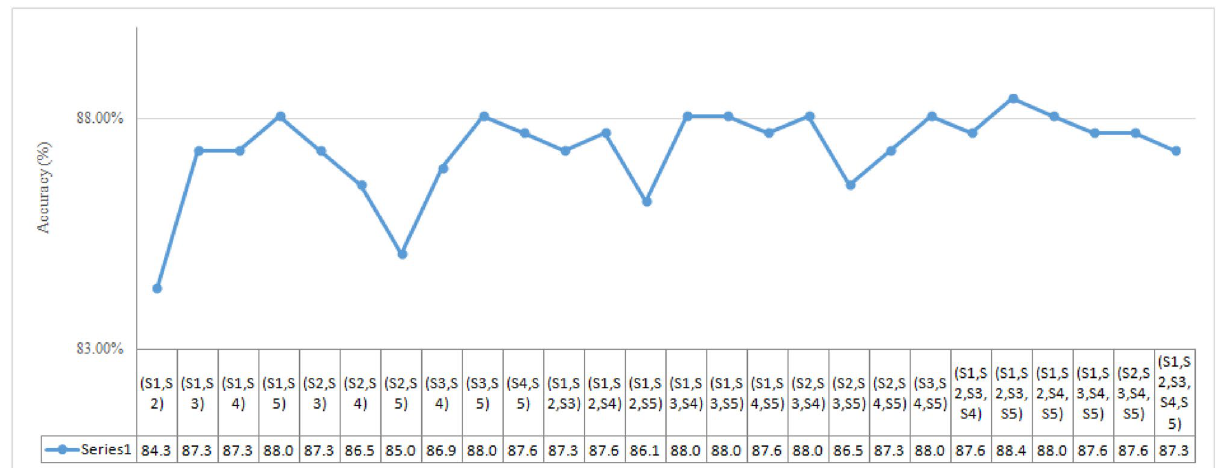
Figure 7. Graph showing the performance of various combinations of Ensemble